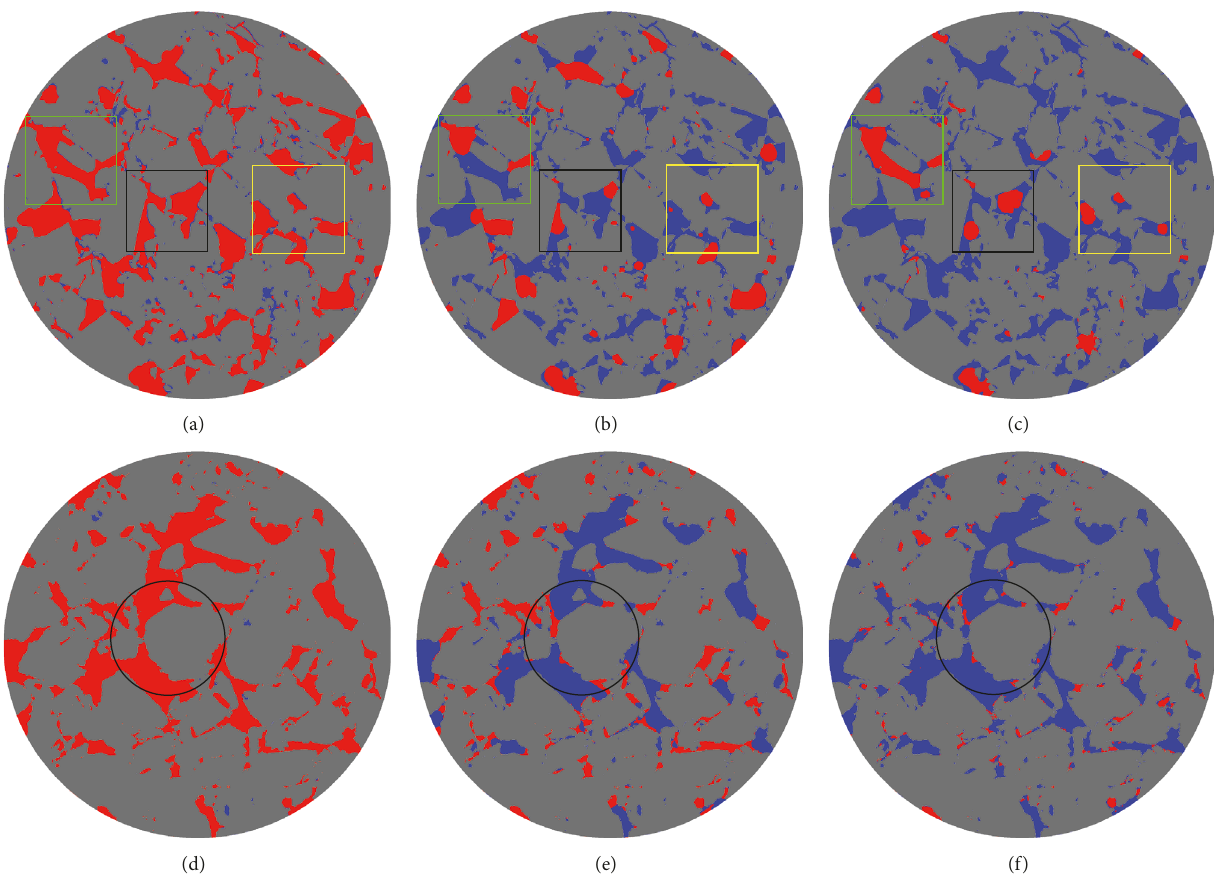
Figure 8: Two-dimensional cross-sectional views (diameter = 1600 voxels) of the pore-scale fluid occupancy in both water-wet (slice = 834, 25.75 mm from the inlet) and oil-wet plugs (slice = 158, 24.33 mm from the inlet). (a) Exp. number 3 in water-wet plug. (b) Exp. number 4 in water-wet plug. (c) Exp. number 3 in water-wet plug. (d) Exp. number 8 in oil-wet plug. (e) Exp. number 9 in oil-wet plug. (f) Exp. number 10 in oil-wet